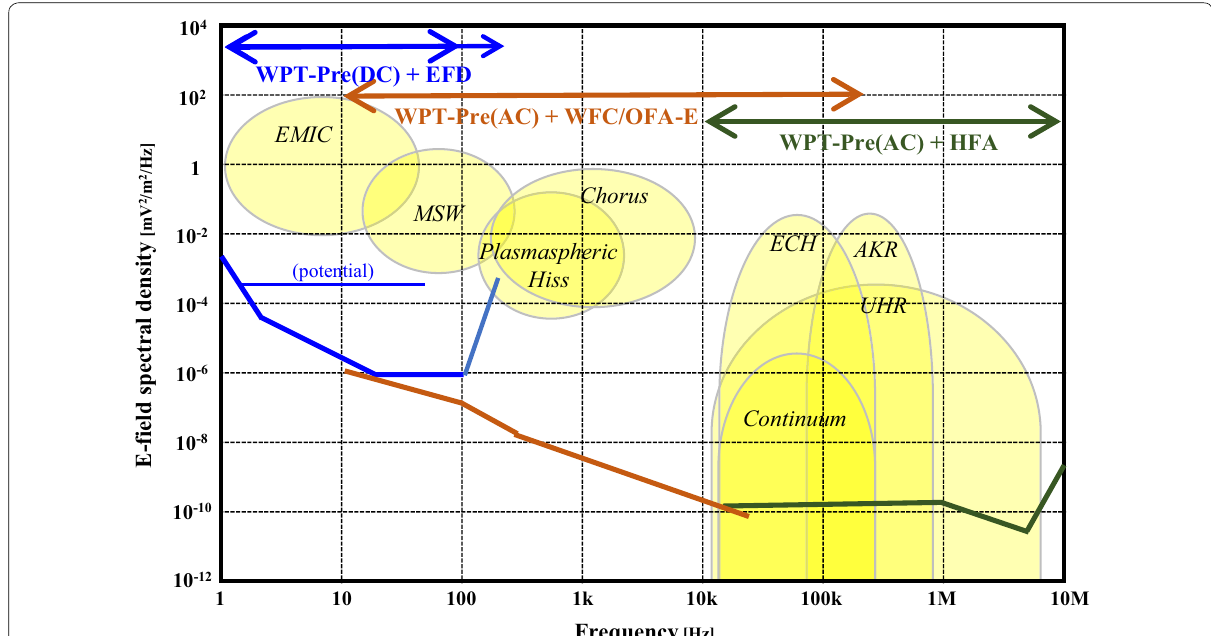
Fig. 4 Electric field wave phenomena as the scientific targets of the ERG mission, and electric field sensor sensitivities and frequency coverage using the WPT and the receivers (EFD, WFC/OFA(E), and HFA)